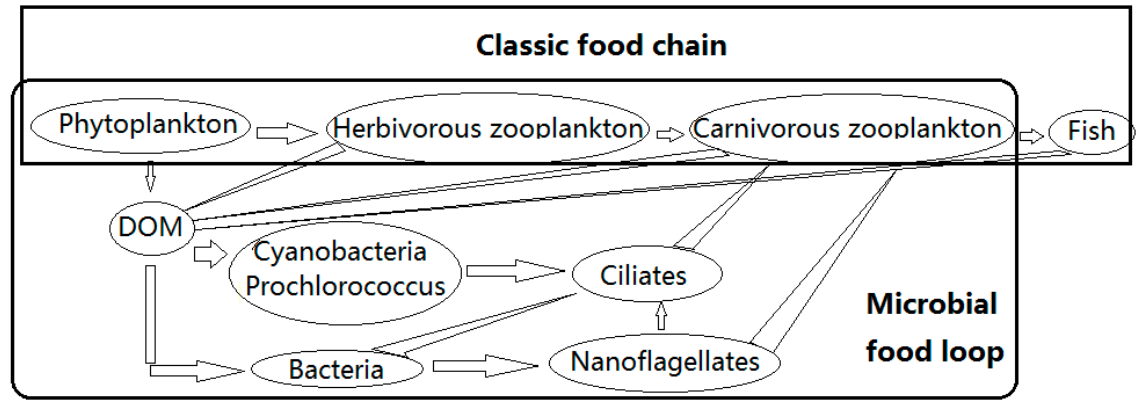
Figure 1. Microbial food loop and classic food chain [3].